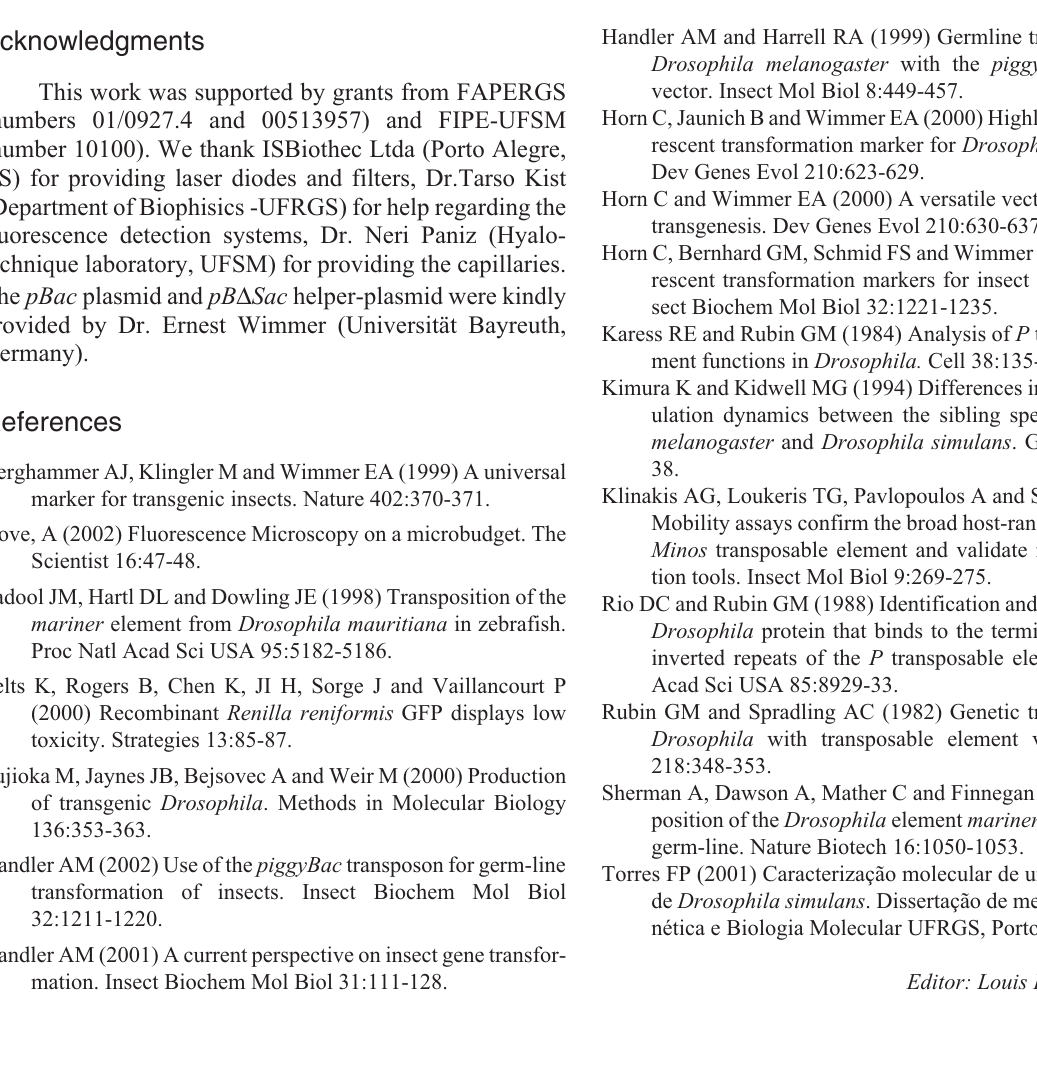
Figure 2 - Stereo-photomicrographs of Drosophila simulans. In the first part of the figure (I) the top fly (A and B) is untransformed and the bottom fly (C and D) is piggyBac GFP transformed. In the second part of the figure (II) the top fly is transformed and the bottom fly is a control. Columns A and C show flies illuminated with white light while columns B and D show flies illuminated with UV